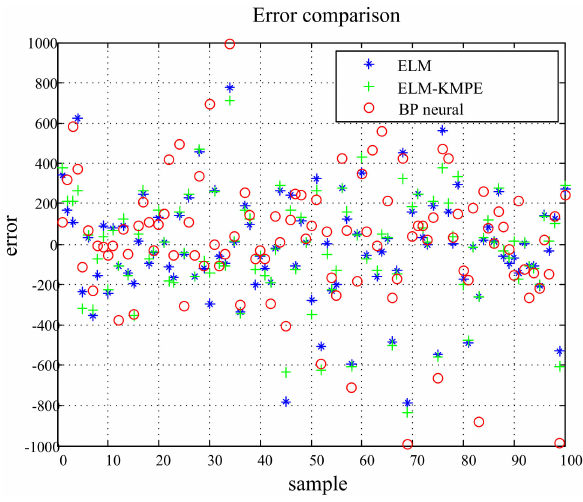
Figure 5. Comparison diagram of three algorithm errors.